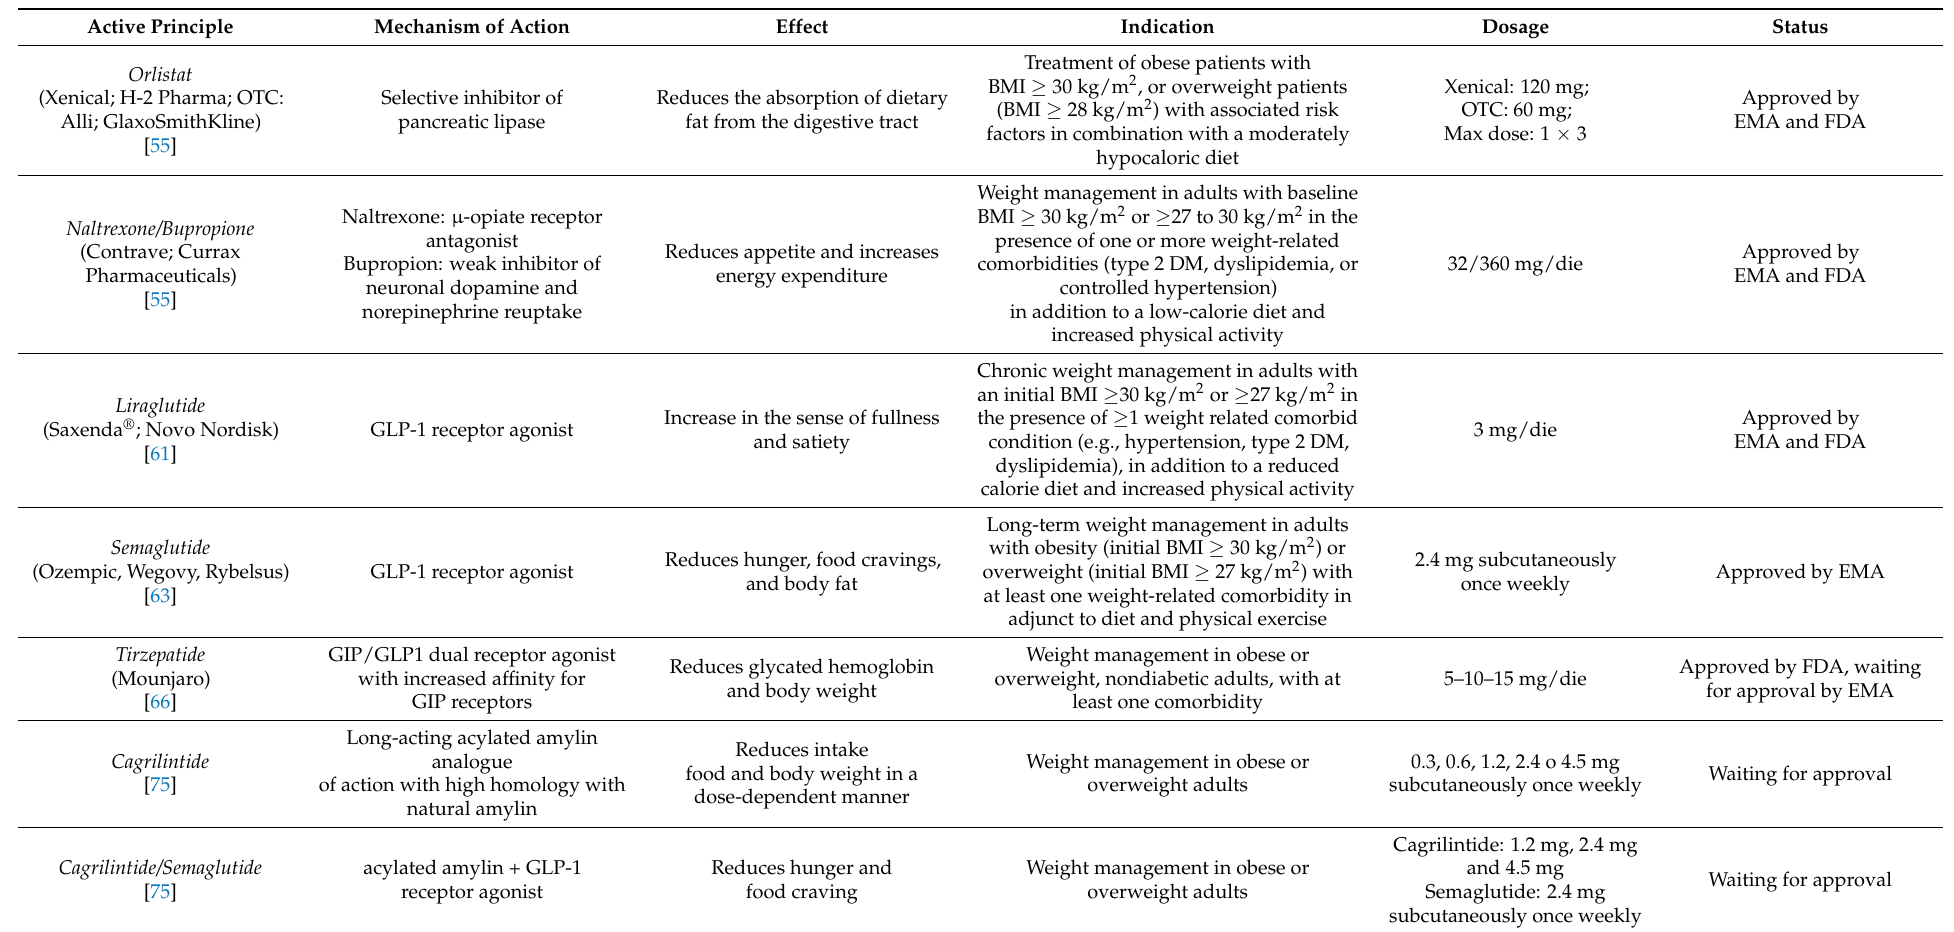
Table 2. Drugs currently available for the treatment of